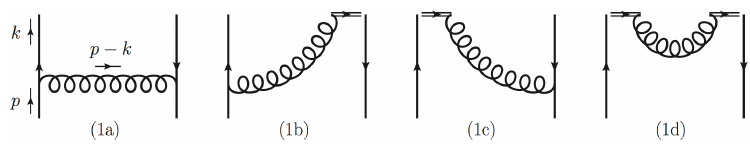
Figure 1: Real diagrams in the QTM at one-loop order.